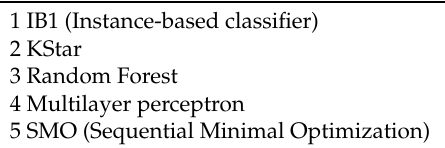
Table 3. Subset of classification algorithms { a 2 } ⊆ A .